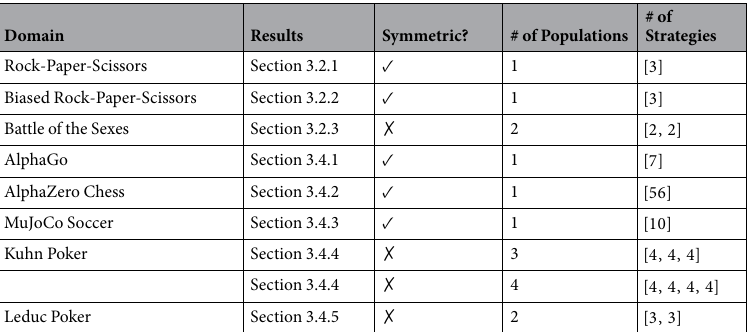
Table 1. Overview of multi-agent domains evaluated in this paper. These domains are extensive across multiple axes of complexity, and include symmetric and asymmetric games with different numbers of populations and ranges of strategies.